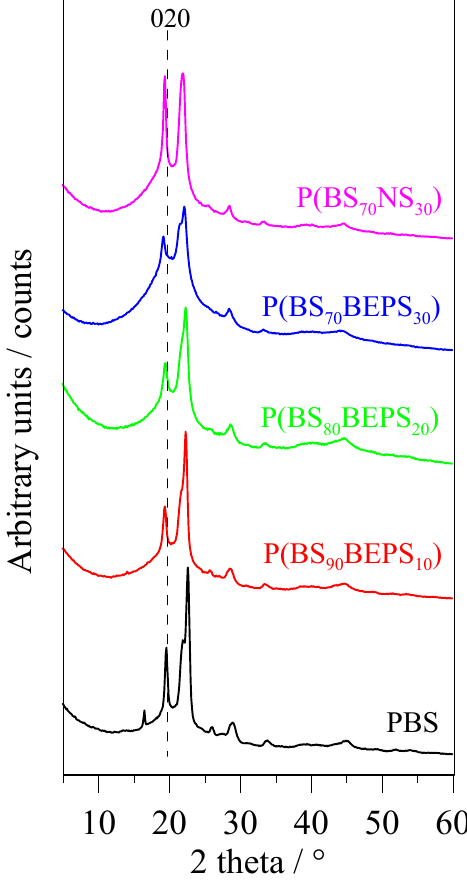
Figure 5. XRD profiles for the polymers under study. For PBS, the 0 2 0 reflection is indicated.